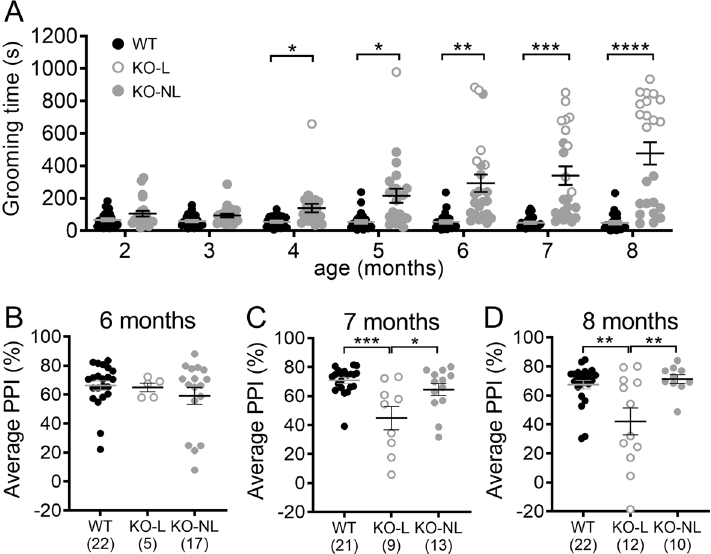
Figure 5. Comparison of the developmental progression of excessive grooming, lesions, and PPI impairment. ( A ) Longitudinal progression of compulsive grooming phenotype in Sapap3-KOs from 2–8 months of age. Unfilled grey symbols are KO-L; grey filled symbols are KO-NL. Grooming was significantly increased in Sapap3-KOs relative to WT from 4 months of age. ( B – D ) PPI was compared between groups at 6–8 months of age when startle did not significantly differ between genotypes (see Figure S5B). Although there are no group differences at 6 months of age, PPI disruption emerges in KO-L at 7 months of age. * indicates significant Bonferroni post-hoc test comparing KO to WT (panel A ) or KO-L to comparison group (panel B – D ). **** p < 0.0001, ** p < 0.01, * p < 0.05. n = 24 WT, 23 KO (panel A ). KO Sapap3 knockout, KO-L KOs with lesions, KO- NL KOs without lesions, WT wild-type, PPI prepulse